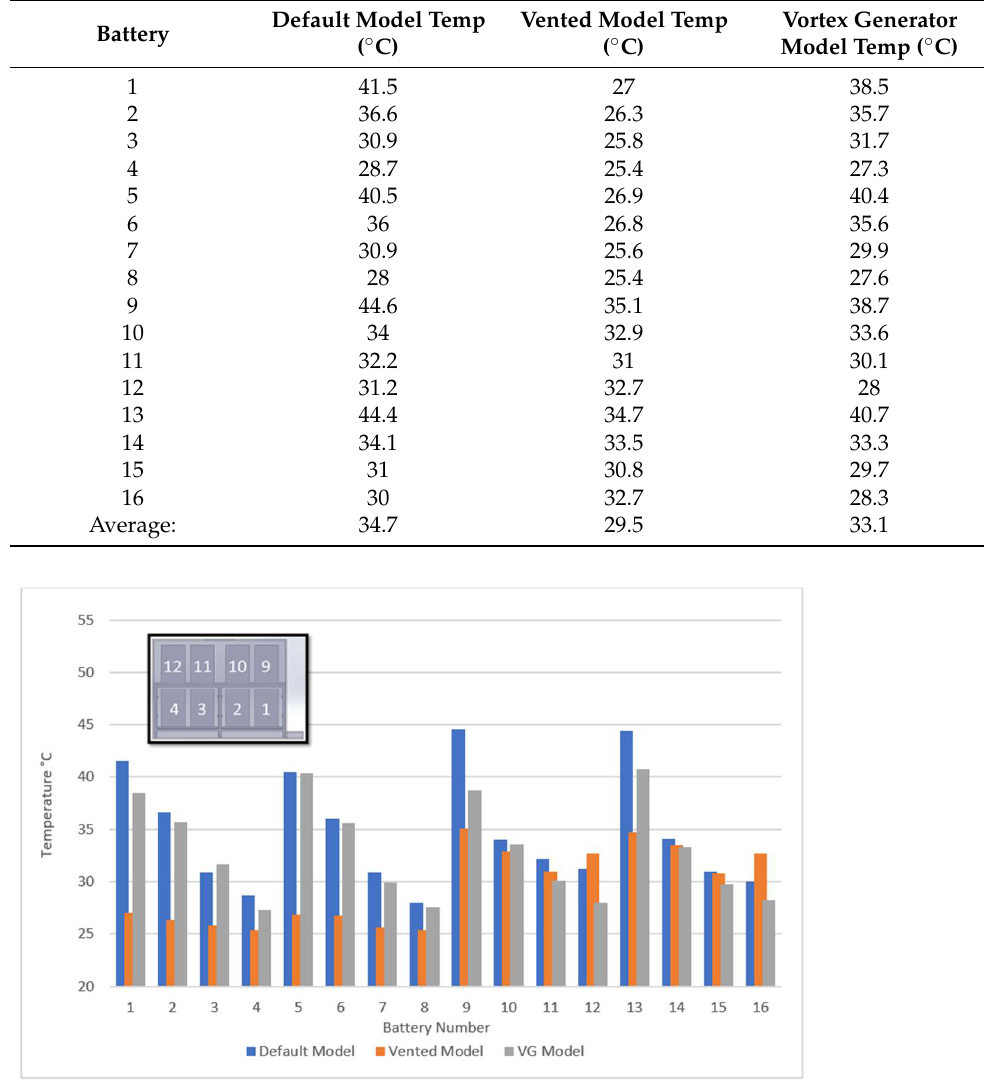
Figure 15. Battery temperature profiles plotted according to assigned number. The pattern for numerical labeling shown in the top right corner repeats for the other side of the case with 9–12 on the lower level of the rack and 13–16 on the top level. Table 7. Temperature differentials across battery series for each of the three